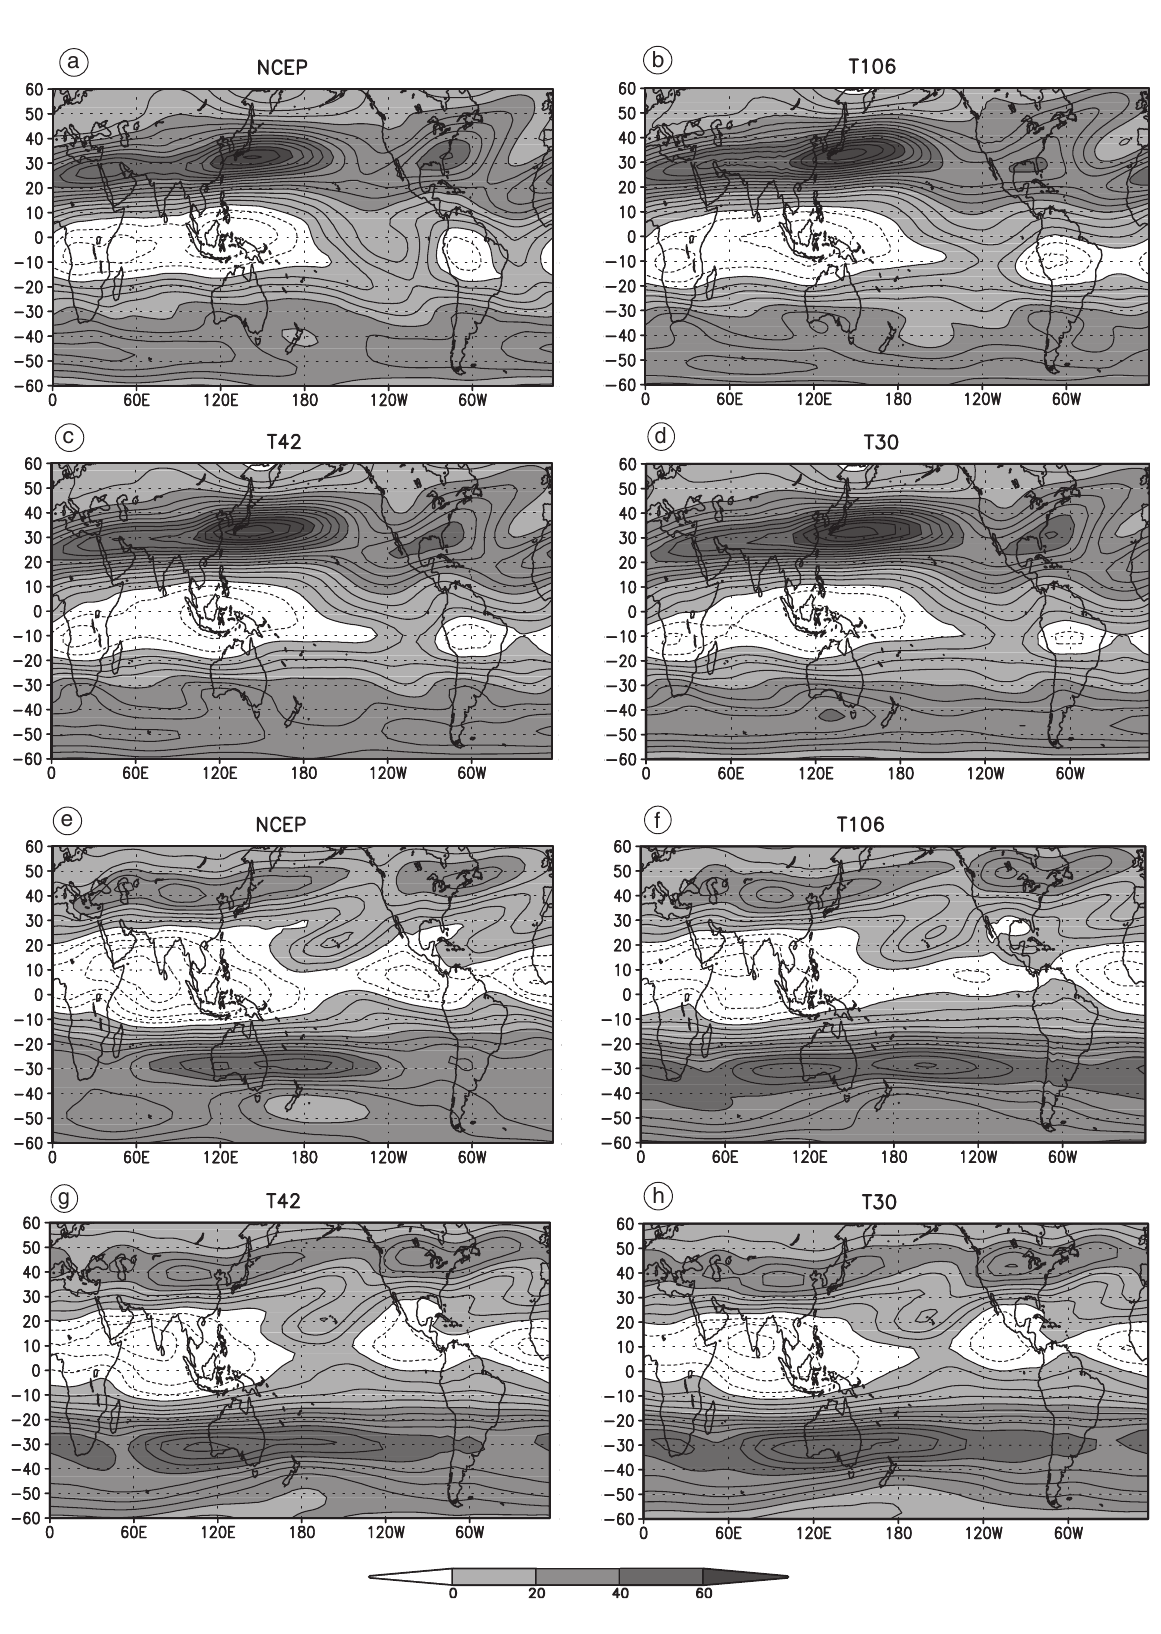
Fig. 6a-h. Same as fig. 4a-h, but for the zonal component of 200-hPa wind. Contour line interval is 5 m/s. Dashed contour lines indicate negative values; shaded areas indicate positive values; shaded contour interval is 10